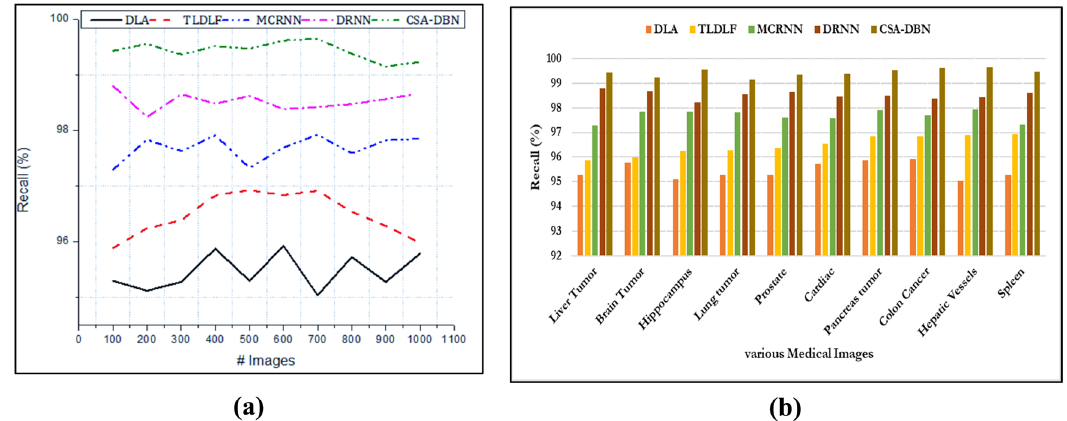
Figure 7: Recall analysis: ( a ) # images and ( b ) di ff erent